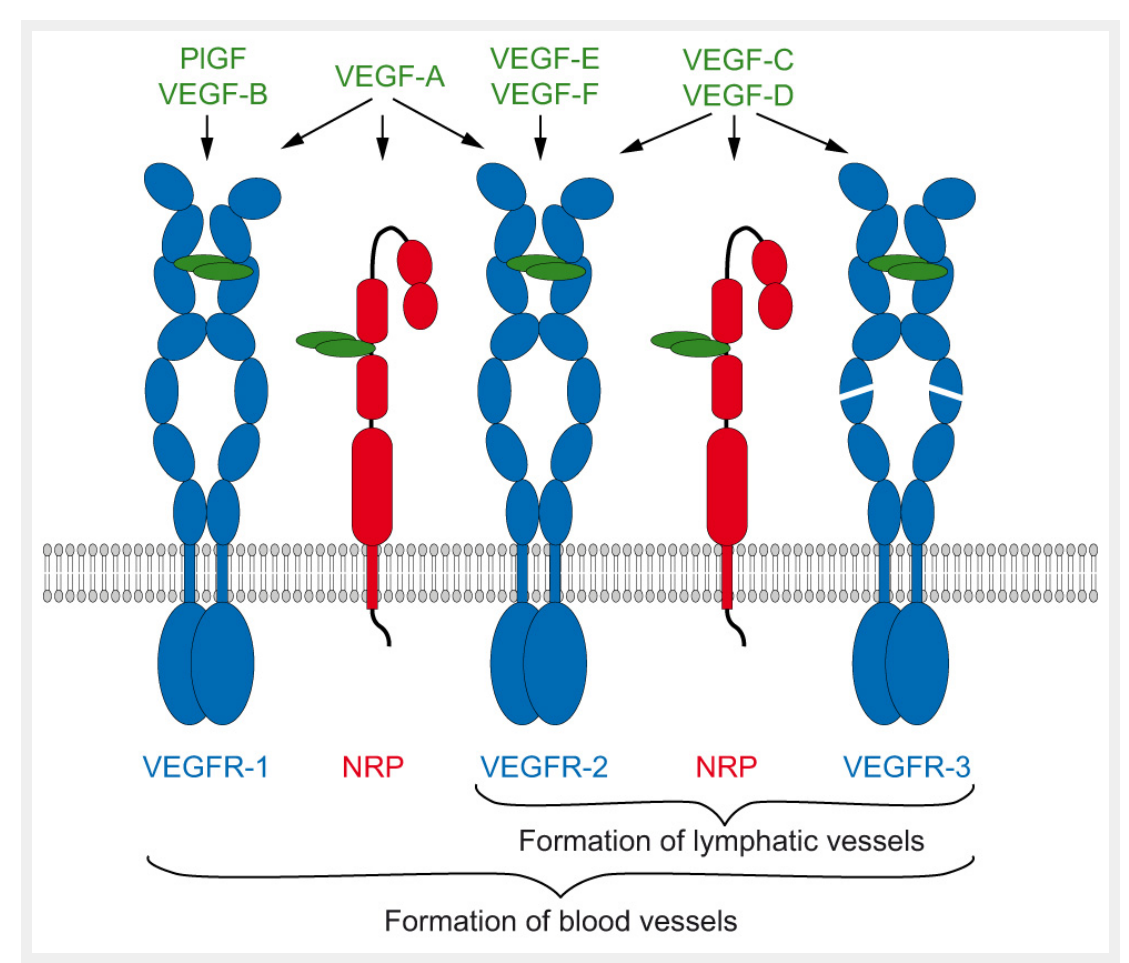
Figure 1 VEGFs and their interactions with VEGFRs and NRPs. The human genome encodes five VEGF genes (A, B, C, D, and PlGF). Two VEGFs are encoded by viruses (E) and snakes (F), respectively. They all exist as dimers and induce dimerisation of the VEGFRs upon binding. Their binding specificity to the three VEGFRs and NRP-1 is indicated by